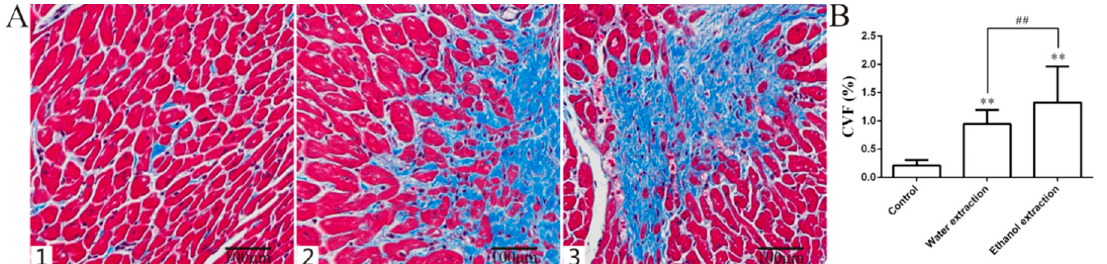
Figure 4. Masson’s trichrome staining of heart tissue and CVF. ( A ) Representative figure of myocardial fibrosis (Masson staining, 200×); ( B ) Statistic results of myocardial fibrosis ( n = 8); 1: Control group; 2: Water extraction group; 3: Ethanol extraction group; data are expressed as mean ± SD. ** p <0.01 vs. control group; ## p < 0.01 vs. water extraction group.